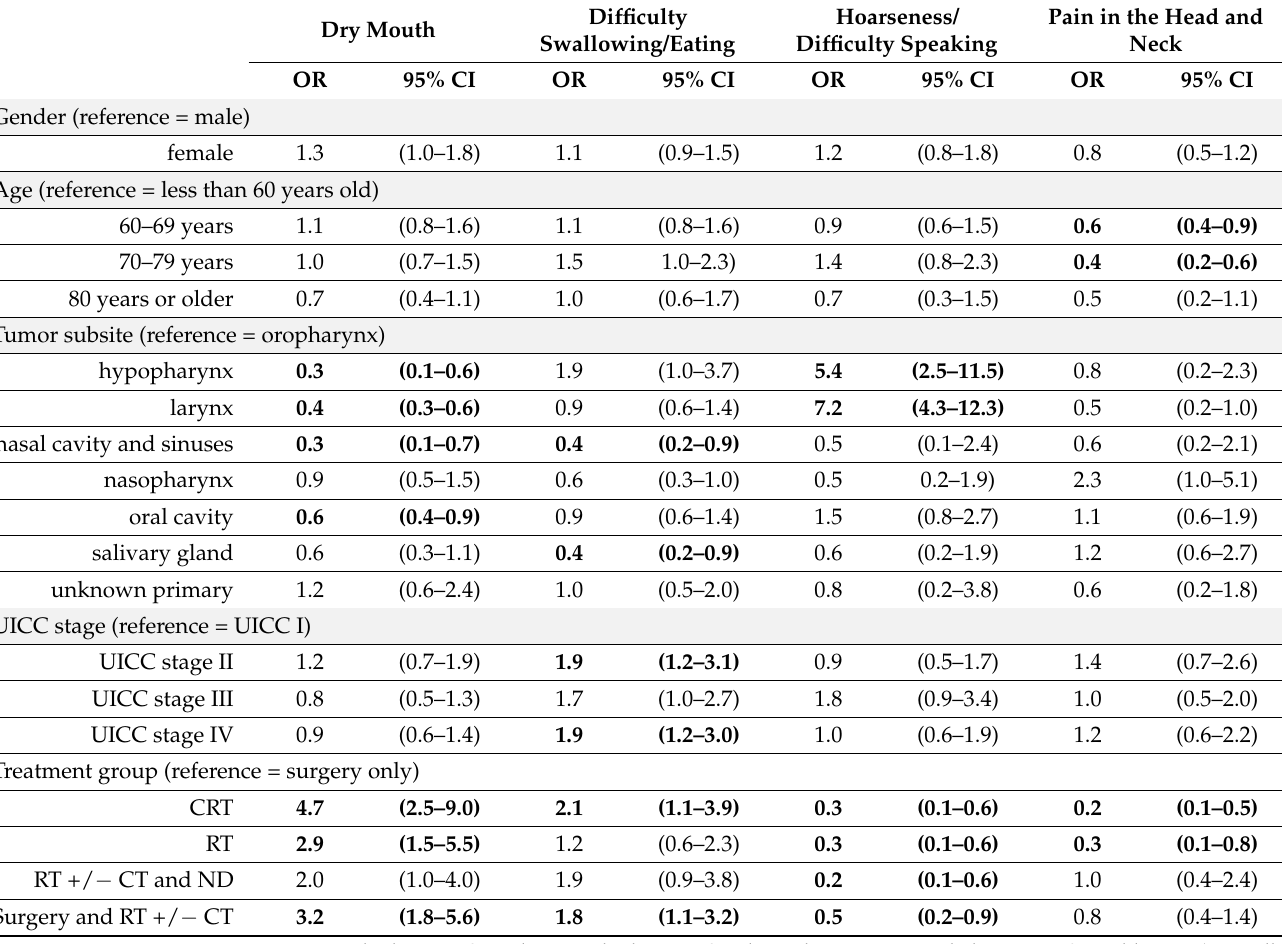
Table 2. Adjusted odds ratios and 95% confidence intervals for issues reported as being a serious long-term effect by head and neck cancer